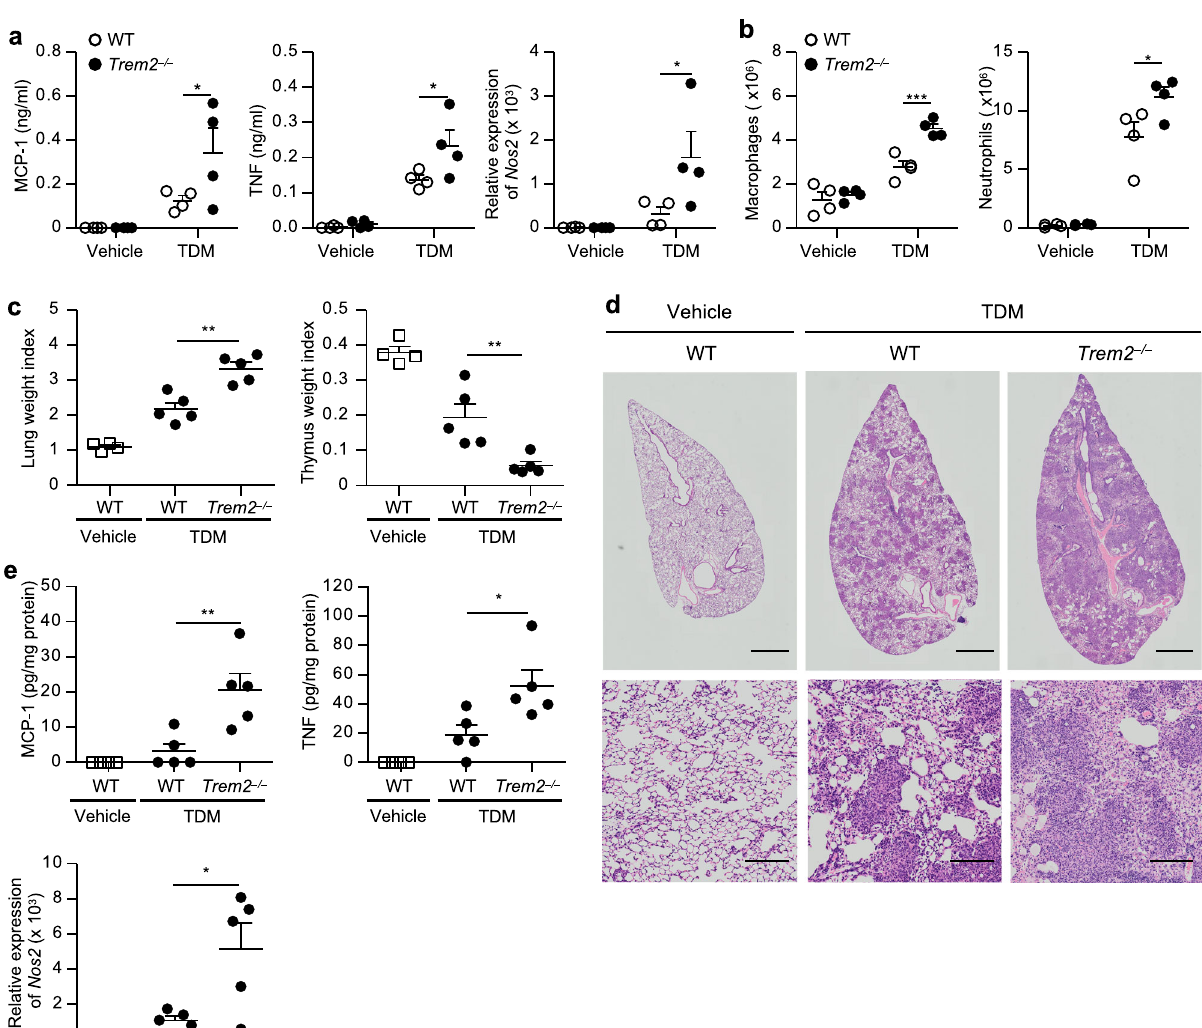
Fig. 6 TREM2 de fi ciency exacerbates Mincle-induced in fl ammation. a , b WT or Trem2 − / − mice ( n = 4) were intraperitoneally injected with 100 μ g TDM or control (vehicle) emulsion. TNF and MCP-1 in the peritoneal lavages were measured by ELISA and Nos2 mRNA levels in the peritoneal cells were measured by qRT-PCR at 24 h post injection ( a ). The numbers of macrophages and neutrophils in the peritoneal cavities at 72 h post injection were analyzed by fl ow cytometry ( b ). c – e WT or Trem2 − / − mice ( n = 5) were intravenously injected with 50 μ g TDM or control emulsion, and the lungs and thymuses were collected at day 7 after the injection. LWI and TWI are shown ( c ). Representative hematoxylin and eosin-stained sections of lung lobes from WT and Trem2 − / − mice (scale bars: upper panels, 1 mm; lower panels, 0.1 mm) are shown ( d ). Cytokine concentration in lung homogenates was measured by ELISA, and Nos2 mRNA levels in the lungs were measured by qRT-PCR ( e ). Data in a – c and e are presented as mean ± SEM and are representative of at least two independent experiments. The statistical signi fi cance was calculated by two-way ANOVA followed by Bonferroni ’ s test ( a , b ) or by two-tailed unpaired t test ( c , e ). * p < 0.05, ** p < 0.01, *** p < 0.001. Source data are provided as a Source data fi